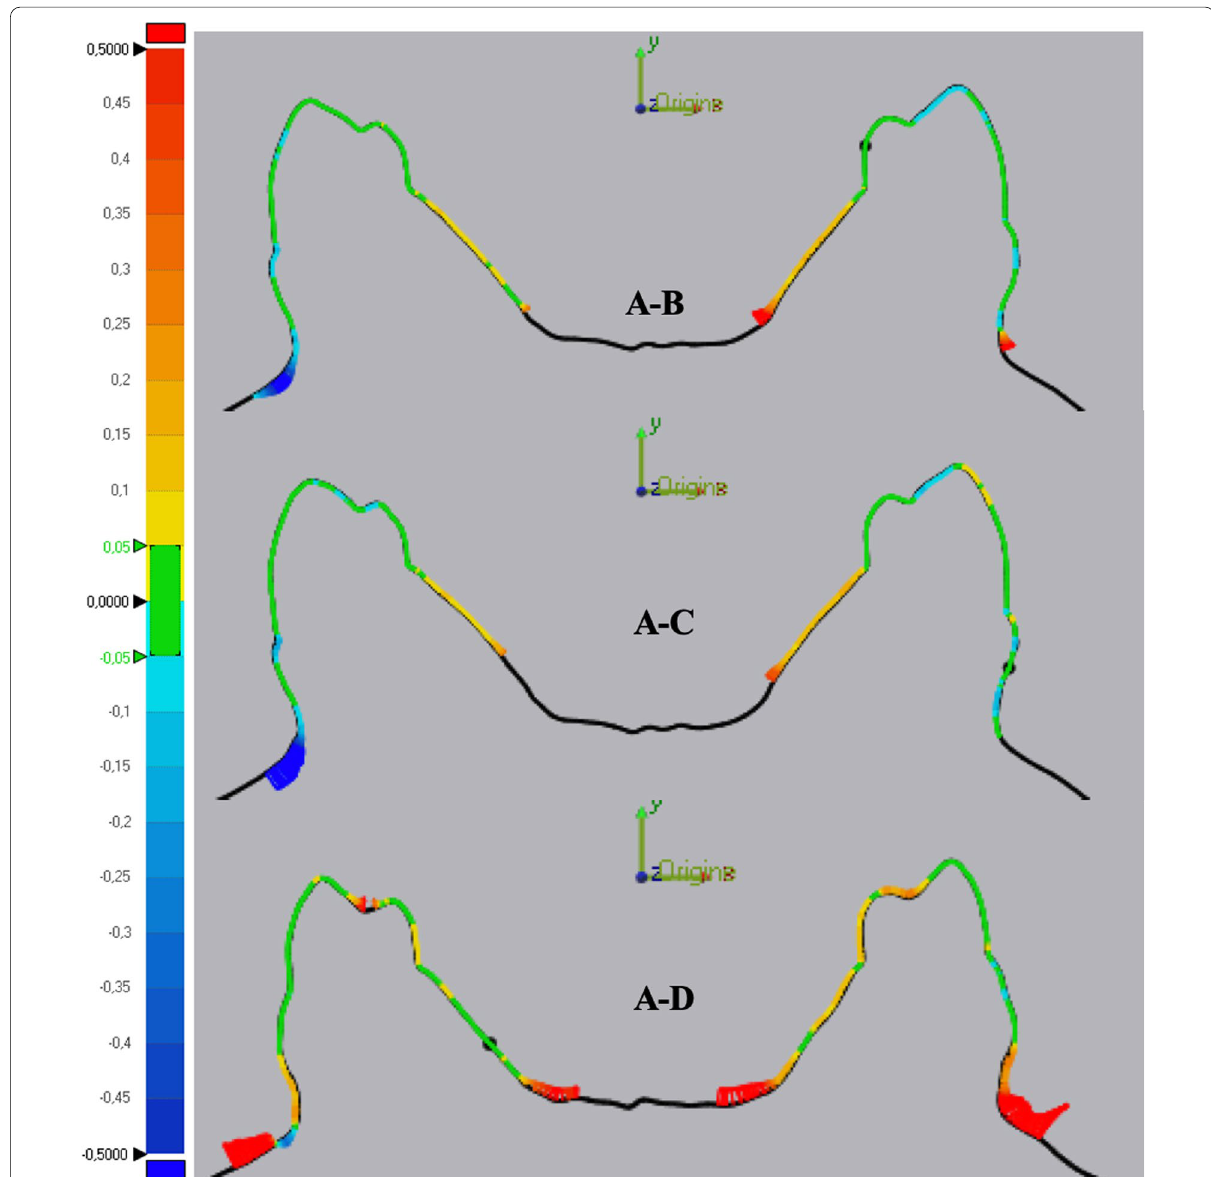
Fig. 3 Cross section of elements 4.4–3.4 comparing units A (PVS impression), B (Carestream CS 3600), C (CEREC Omnicam) and D (Trios